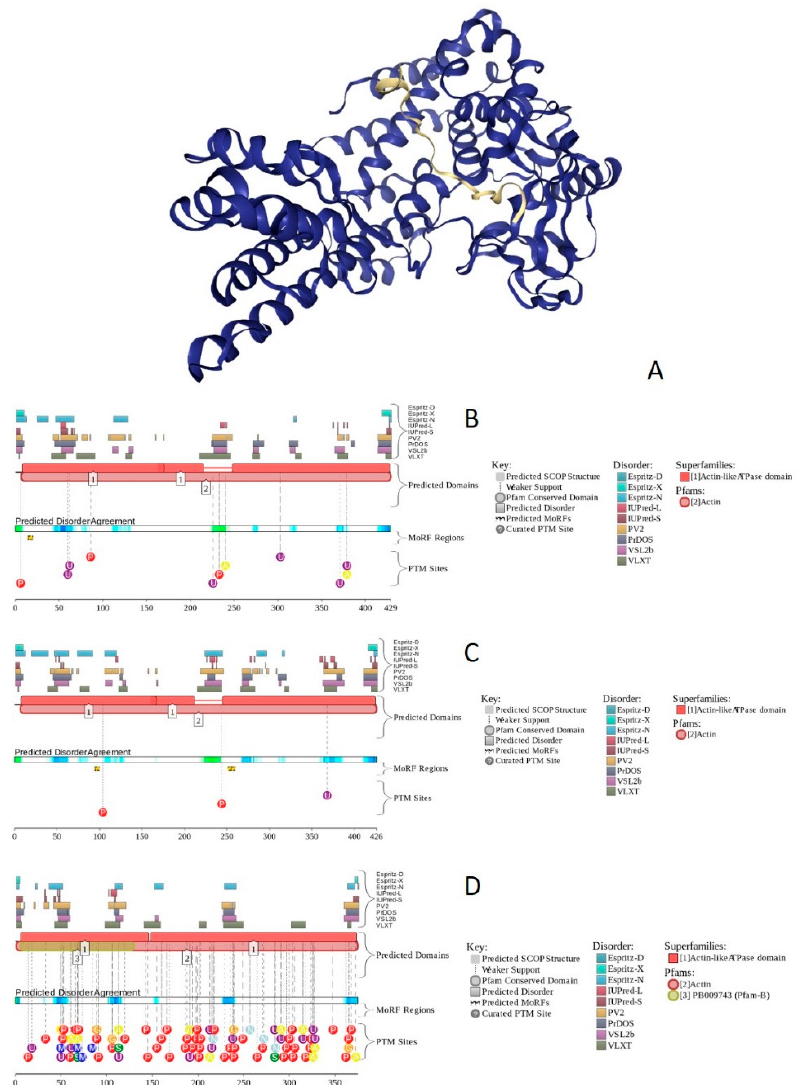
Figure 22. Structure, intrinsic disorder, and functionality of human BAF53A / ACTL6A, BAF53B / ACTL6B, and β -actin / ACTB. ( A ) X-ray crystal structure of a short actin peptide (residues 66–88, yellow structure) co-crystallized with human histone-lysine N-methyltransferase (blue structure) (PDB ID: 6ICT). ( B) D 2 P 2 functional disorder profile of human BAF53A / ACTL6A (UniProt ID: O96019). ( C ) D 2 P 2 functional disorder profile of human BAF53B / ACTL6B (UniProt ID: O94805). ( D ) D 2 P 2 functional disorder profile of human β -actin / ACTB (UniProt ID: